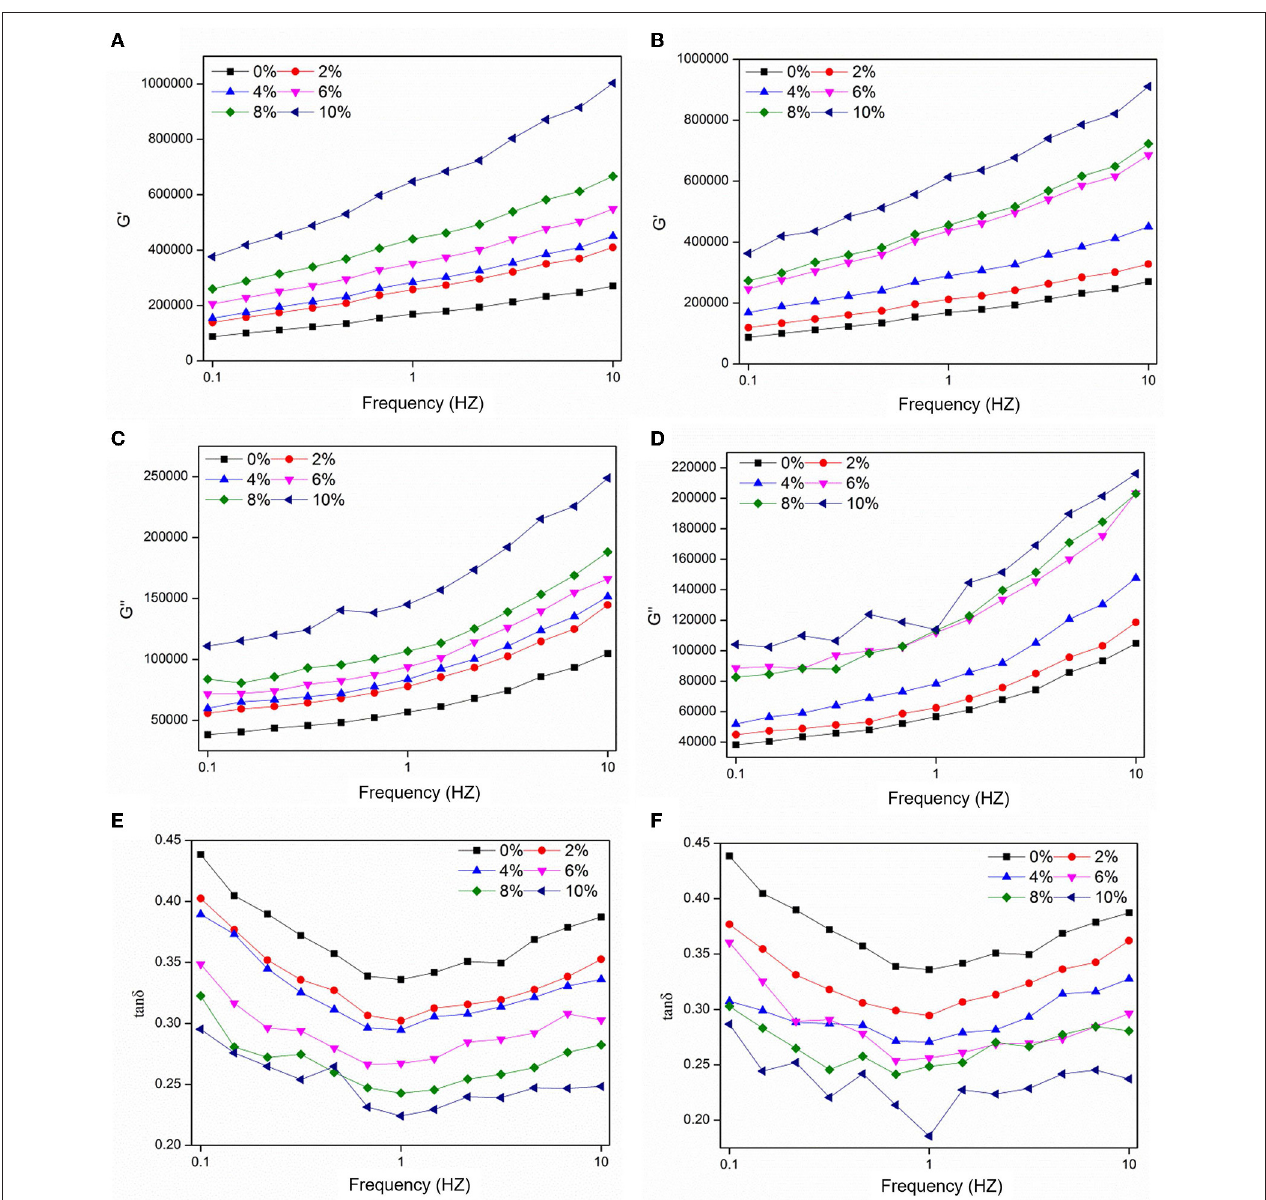
FIGURE 1 | Effect of UWBDF and FWBDF addition on frequency scan curve of dough: (A,C,E) dough with UWBDF and (B,D,F) dough with